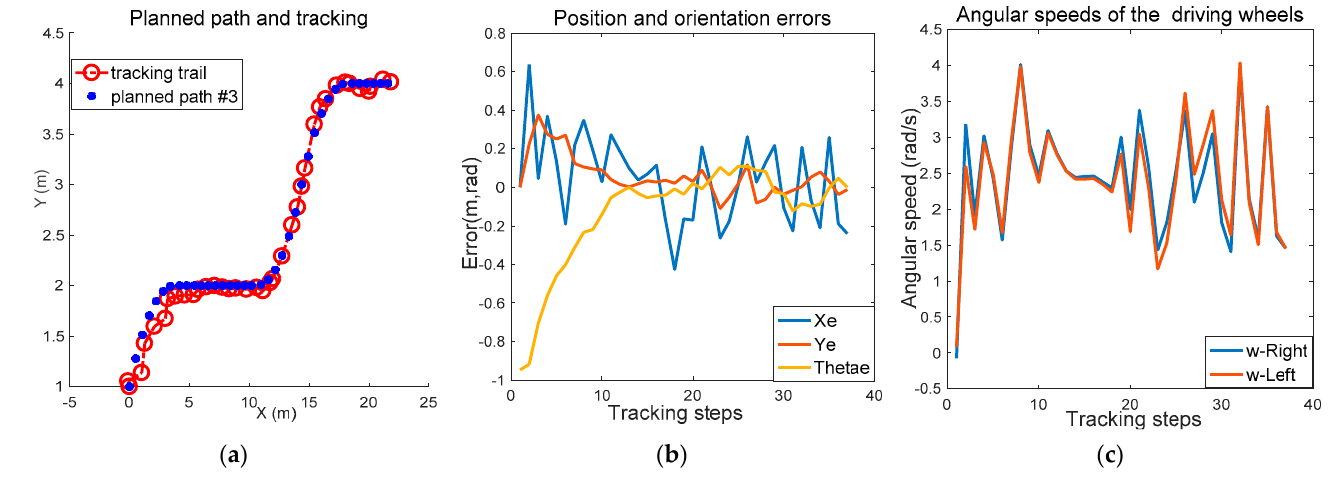
Figure 11. The pre-designed transition path for the yawed roadheader.